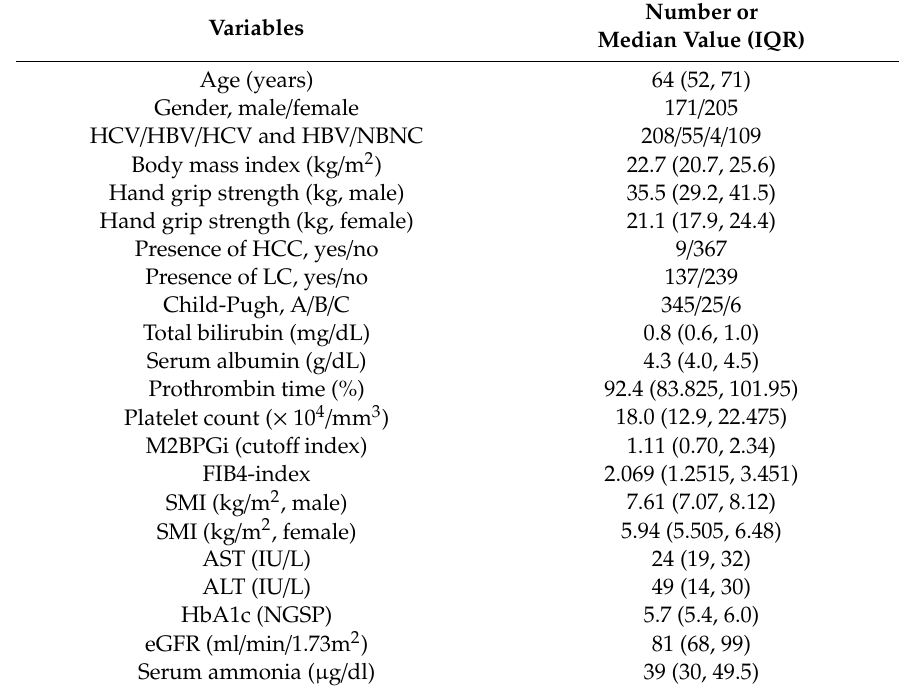
Table 1. Baseline characteristics ( n =